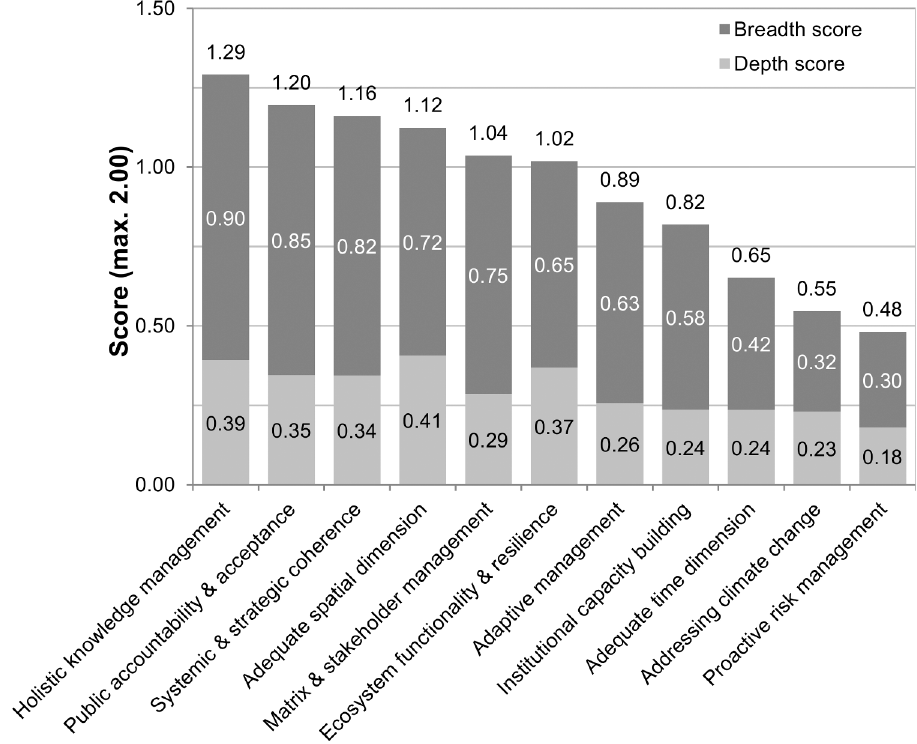
Fig 5. Standardised breadth, depth and total quality scores of the eleven robustness principles in descending order of total quality. Breath score = Number of plans that addressthe principle(max. 1.00), depth = intensity of addressing the principle(max 1.00), total quality= sum of breadth and depth score (max. 2.00).